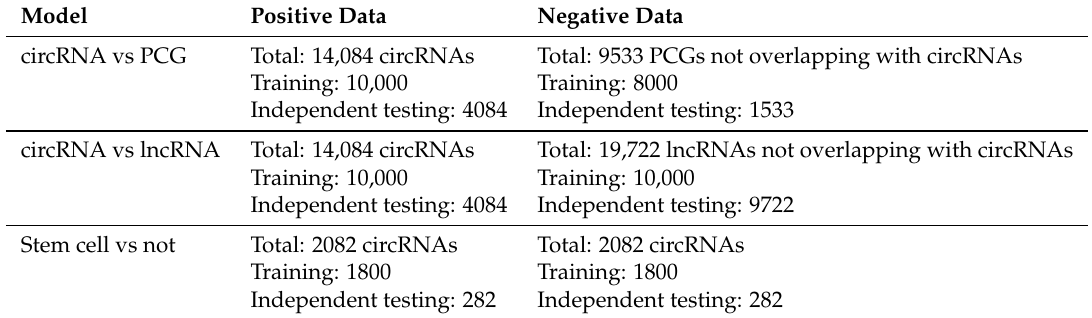
Table 1. The details of training and independent test sets. The table summarizes which sequences were used as positive and negative examples for the respective random forest (RF) models.